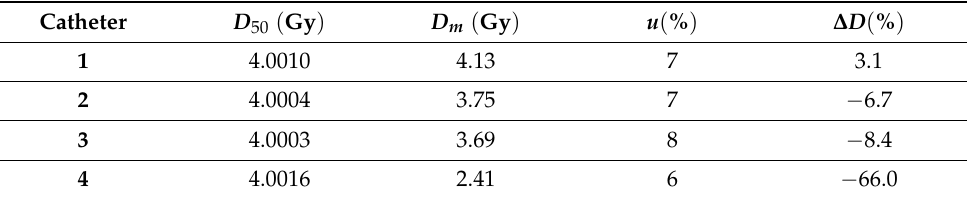
Table 9. D m compared to TPS calculated dose D 50 for the 1 mm slice thickness plan with four active dwell positions. The relative standard uncertainty u (%) with k = 2 is also shown along with percent differences between planned and measured doses.